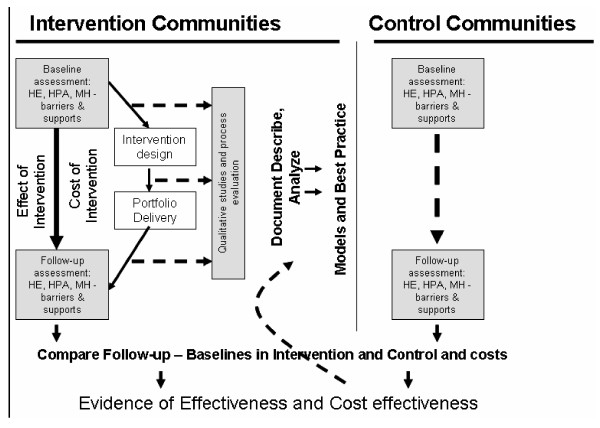
Evaluation design.